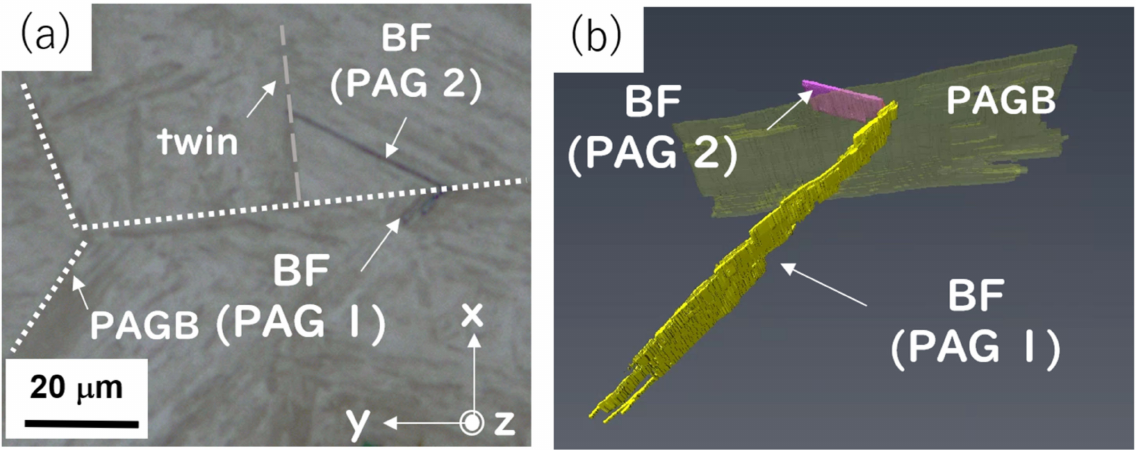
Figure 3. ( a ) The OM image of BFs, and ( b ) the corresponding three-dimensional